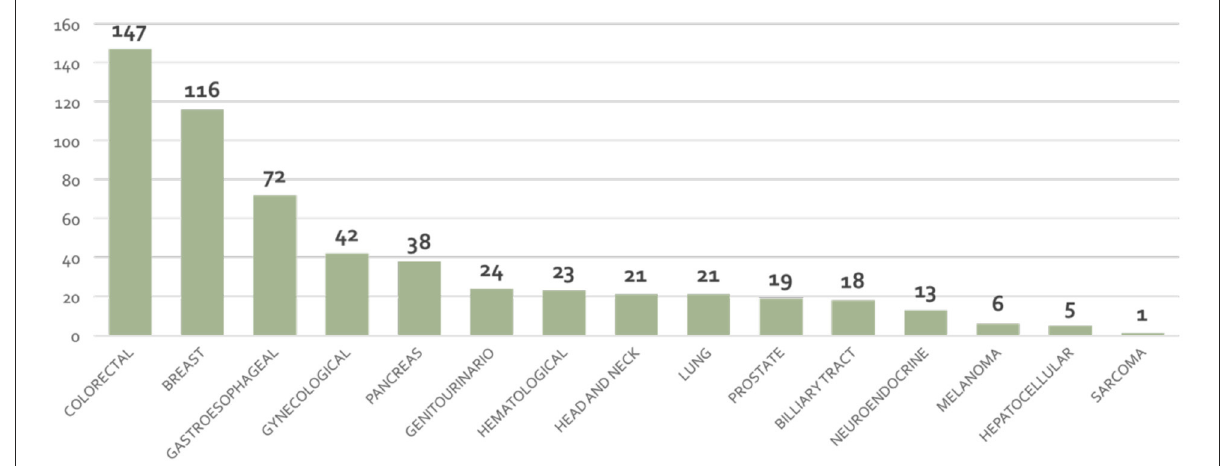
FIGURE1 Distribution of cancer diagnoses of the series of 561 patients.